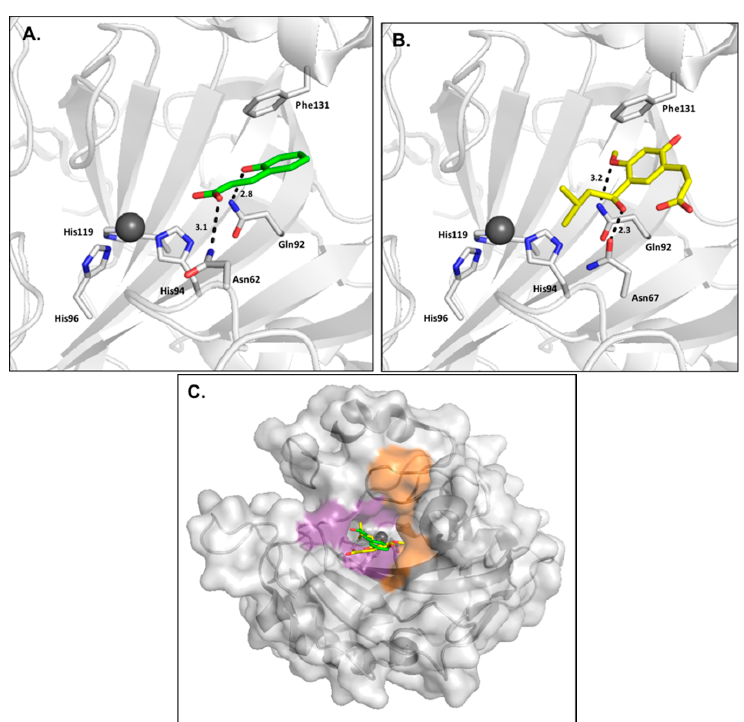
Figure 8. ( A ) Trans-2-hydroxycinnamic acid ( green ) in complex with CA ΙΙ ( gray ) (PDB:5BNL) [50]; ( B ) (2 Z )-3-{2-hydroxy-5-[(1 S )-1-hydroxy-3-methylbutyl]-4-methoxyphenyl}prop-2-enoic acid ( yellow ) in complex with CA ΙΙ ( gray ) (PDB:3F8E) [49]; ( C ) Overlay of coumarin inhibitor hydrolysis products in CA ΙΙ surface.